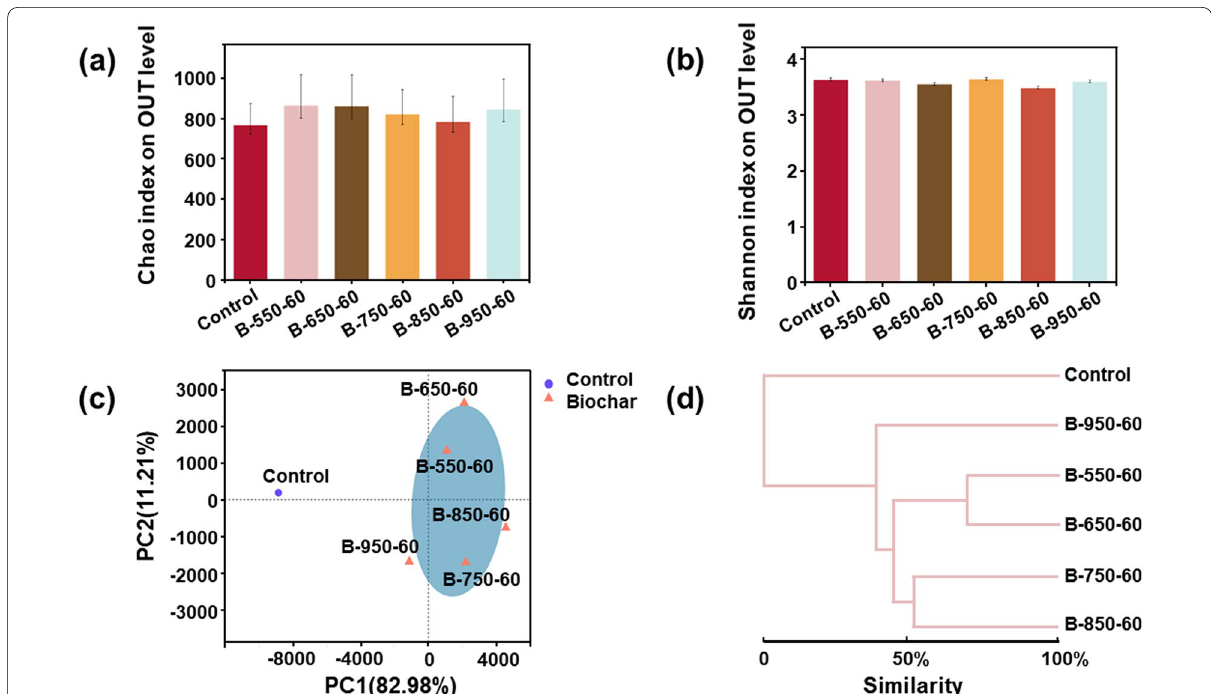
Fig. 3 Effects of carbon-based materials on microbial community Chao1 ( a ) and Shannon ( b ) index. c PCA analysis based Bray–Curtis distances comparing the composition of microbial community structure under different conditions. d Dendrograms comparing the level of similarity among all 6